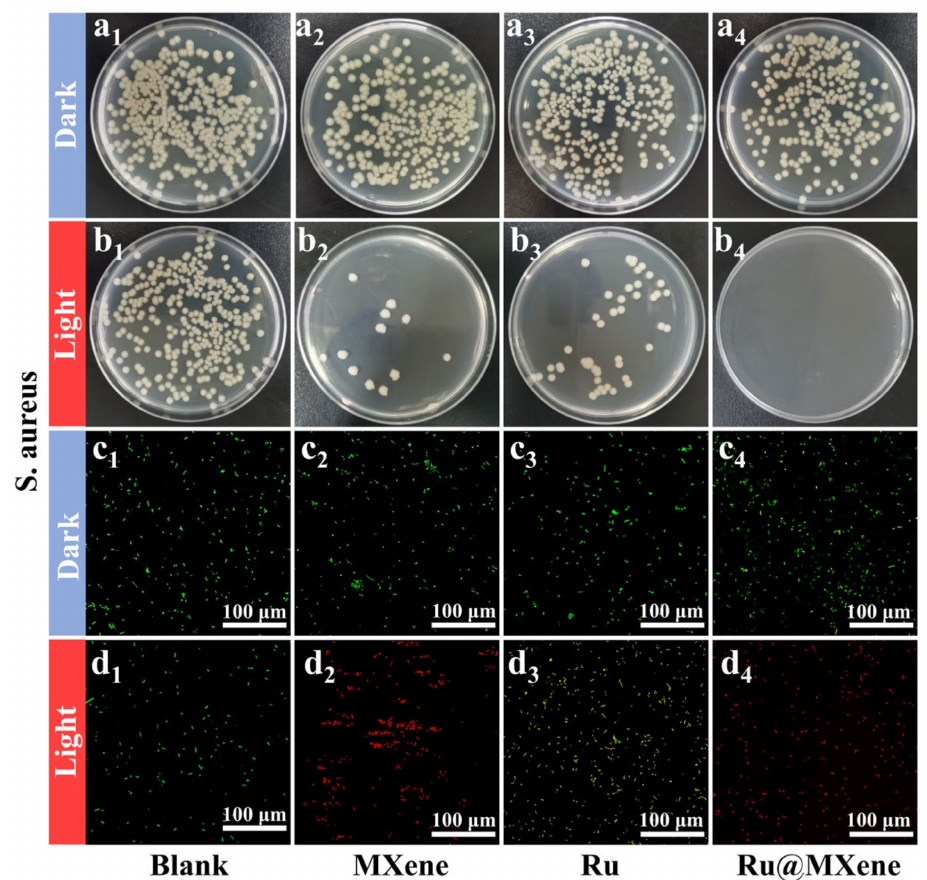
Figure 8. Antibacterial activities: bacterial suspensions without any material were used as control ( a 1 – d 1 ). Spread plate results of S. aureus treated with MXene ( a 2 , b 2 ), Ru ( a 3 , b 3 ) and Ru@MXene ( a 4 , b 4 ) after exposure in the dark or illumination with xenon lamp (150 mW/cm 2 , 30 min). Corre- sponding confocal images of live/dead fluorescence of S. aureus on MXene ( c 2 , d 2 ), Ru ( c 3 , d 3 ) and Ru@MXene ( c 4 , d 4 ) with or without xenon lamp (150 mW/cm 2 , 30 min).